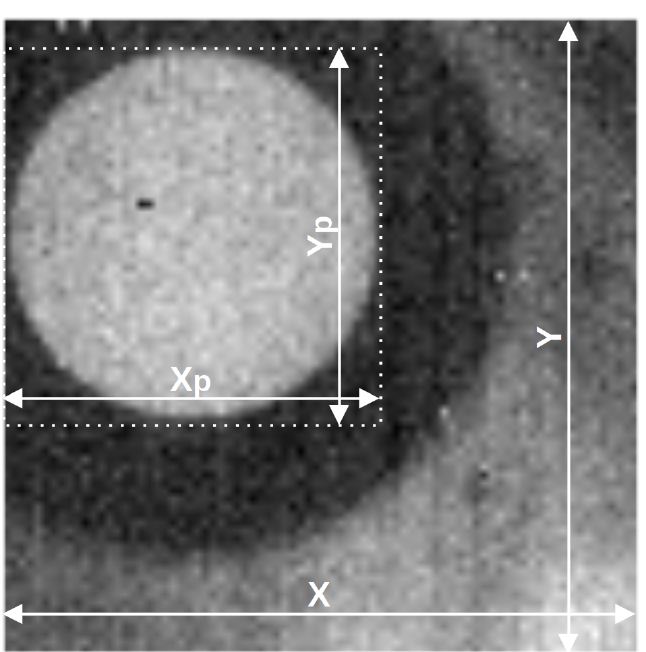
Figure 4. Image captured by Rx camera after nonuniformity correction. In the highlighted square, the Tx camera’s lens is